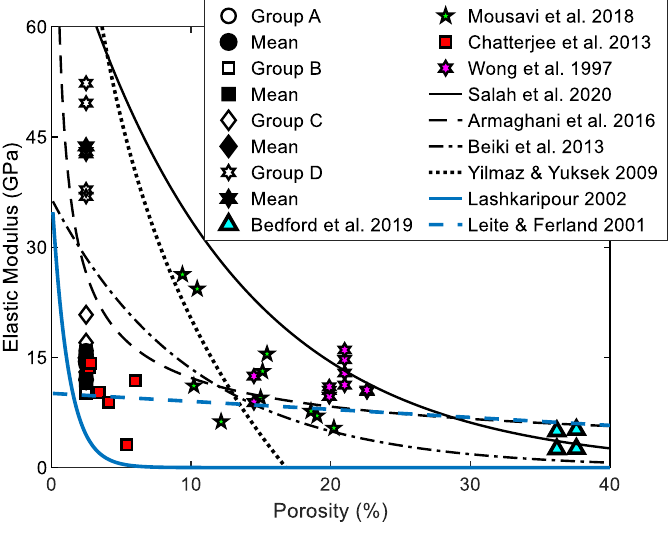
Figure 12. Elastic modulus and prediction. Table 8. Empirical expressions for elastic modulus prediction.